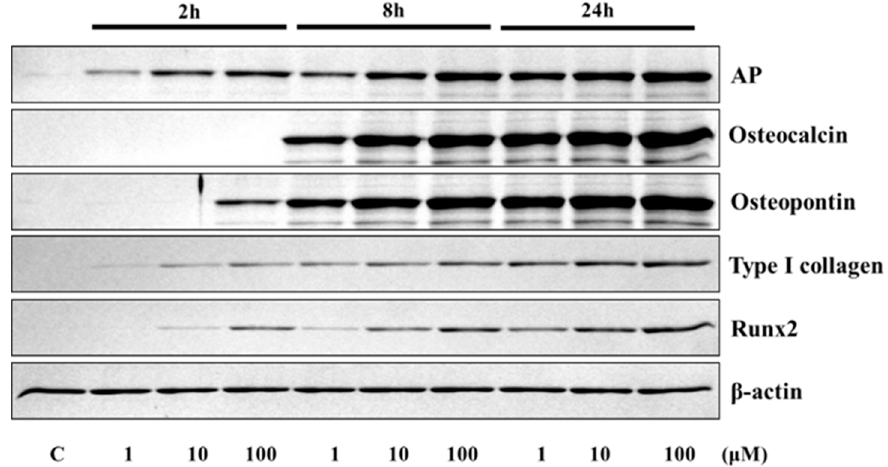
Figure 2. Western blot analysis for alkaline phosphatase (AP), osteocalcin, osteopontin, type I collagen, and runt-related transcription factor 2 (RUNX2). Expression levels were increased after 4HR administration.